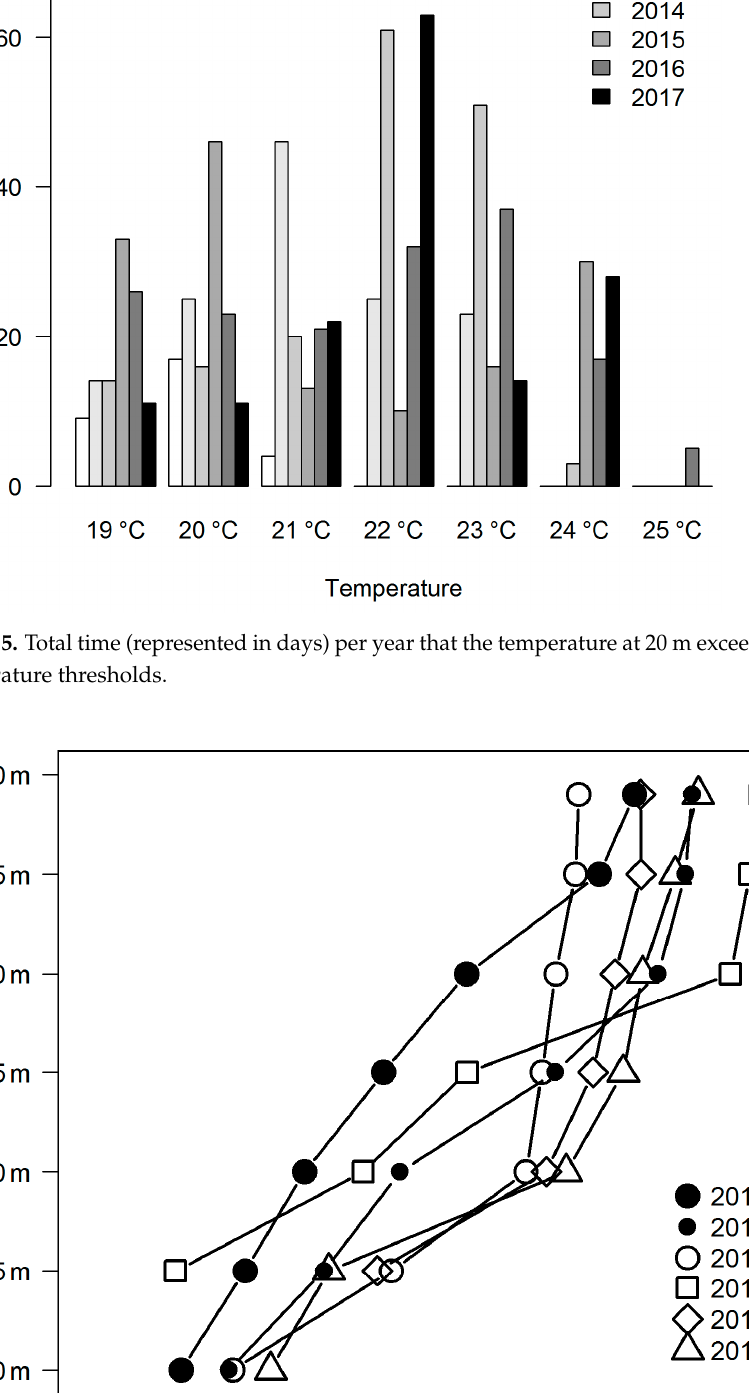
Figure 6. Summer (July/August) mean temperature in the Calvi bay area from 2012 to 2017.